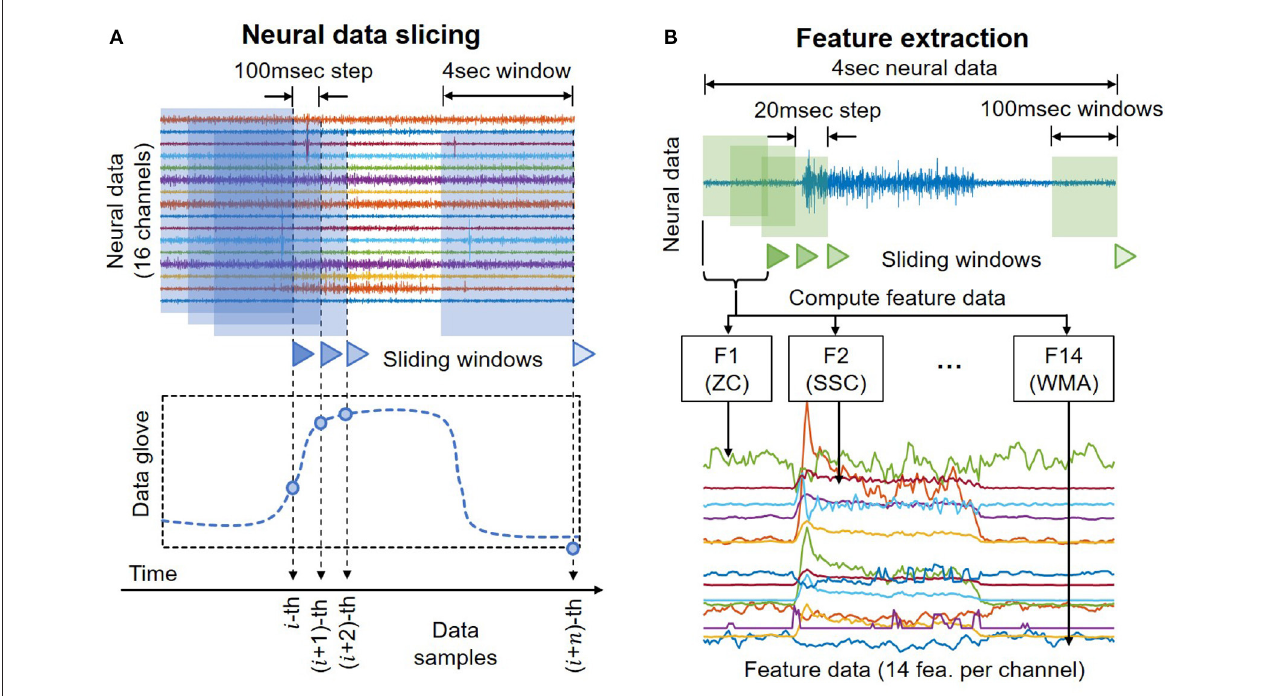
FIGURE 3 | (A) Illustration of the sliding windows to cut neural data to create a pseudo-online dataset that resembles conditions in online decoding. (B) Illustration of the process to compute the feature data.